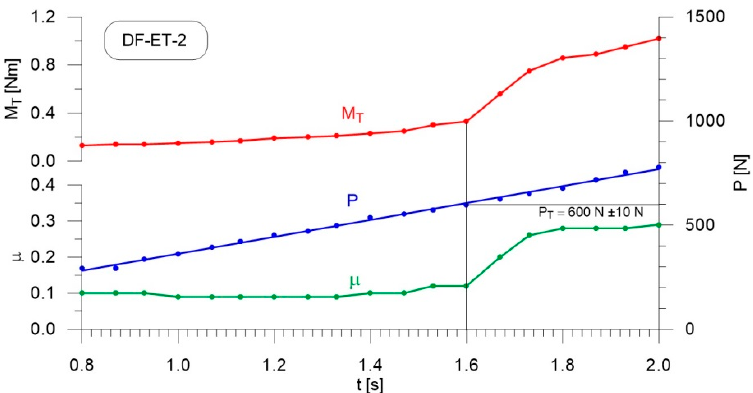
Figure 5. Courses of the load, P, the friction torque, M T , and the friction coefficient, µ, for diesel– ethanol blend with a 2% ethanol volume fraction.